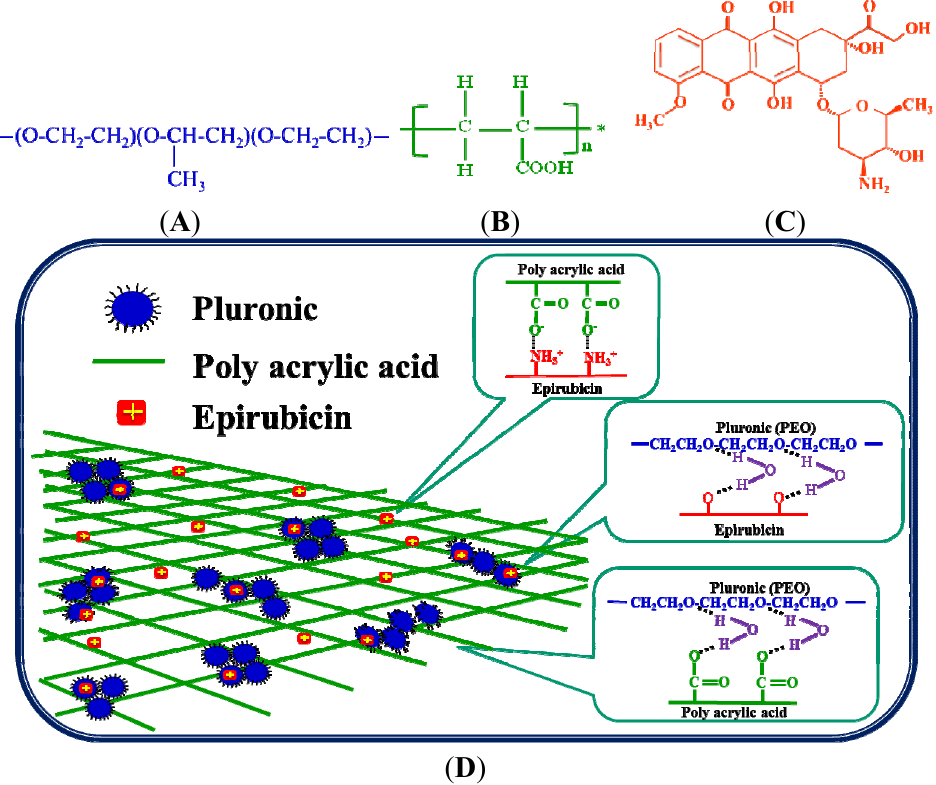
Figure 1. Chemical structure of ( A ) pluronic (Plu); ( B ) polyacrylic acid (PAA); ( C ) epirubicin (Epi); ( D ) semi-interpenetrating network structure of the Plu/PAA/Epi